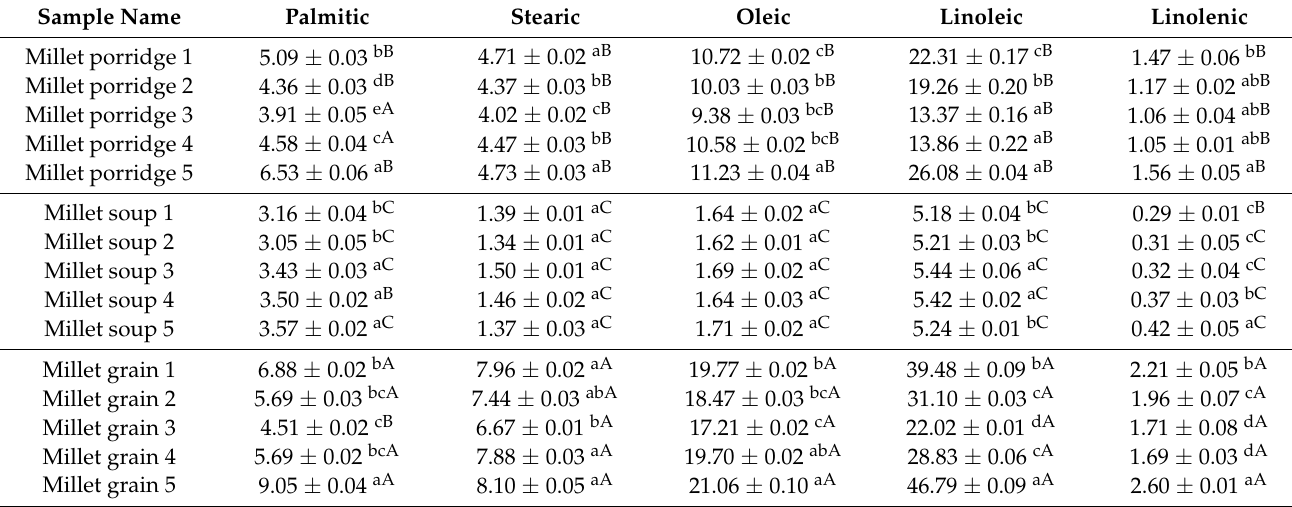
Table 4. Content of fatty acids in millet porridge cooked in different electric